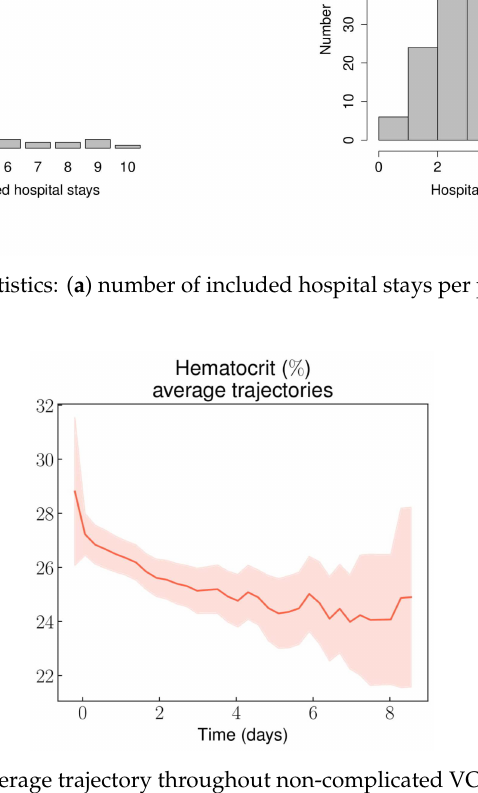
Figure A2. Hematocrit average trajectory throughout non-complicated VOC-related hospital